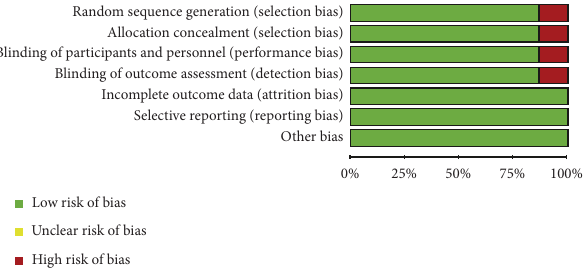
Figure 5: Te results of Cochrane Risk of Bias Tool for the evaluation of clinical trial quality.